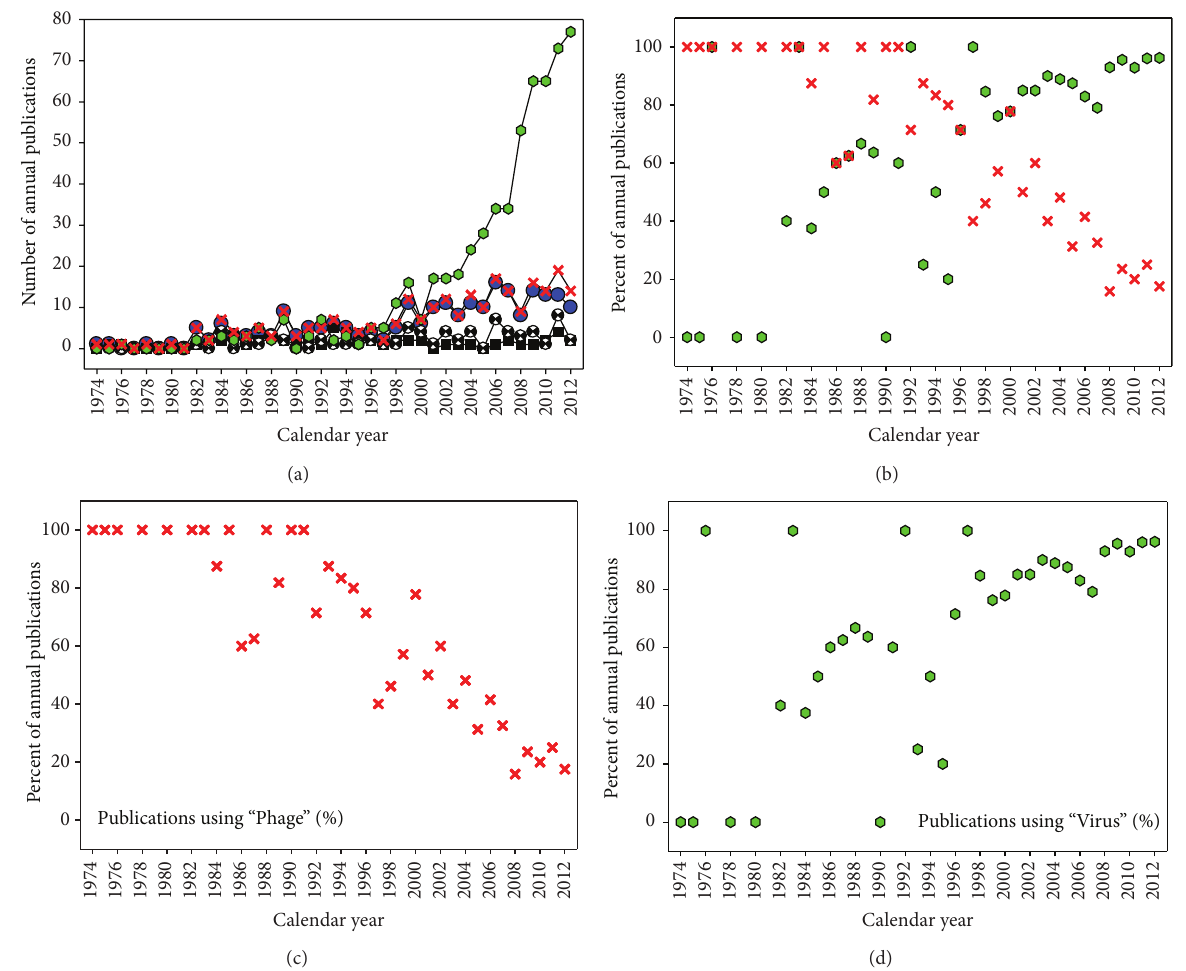
Figure2:Countingpublicationsusing“Virus”(greenhexagons),“Phage”(bluecircles),“Halophage”(blacksquares),“Prophage”(“hourglass” circles), and an aggregate of all three phage terms, “All phage” (red Xs) to describe archaeal viruses. Presented are (a) the absolute number of publications, (b) the relative number of “All phage” versus “Virus”, (c) just “All phage”, and (d) just “Virus” (with (c) and (d) provided solely for clarity rather than to provide additional information). Shown are numbers of “Yes” statuses as indicated in Table 1, supplementary materials, but not “Yes/No” nor “No”